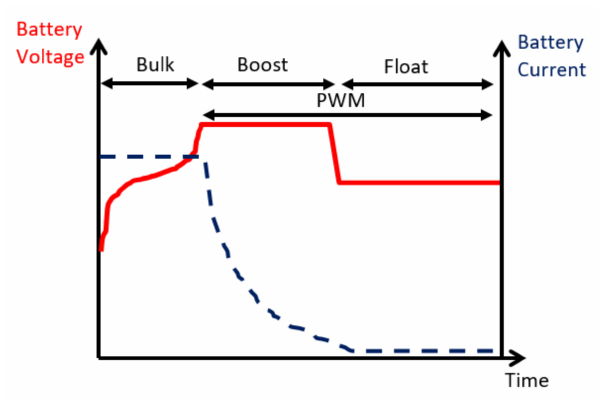
Figure 2. Charge controller charging